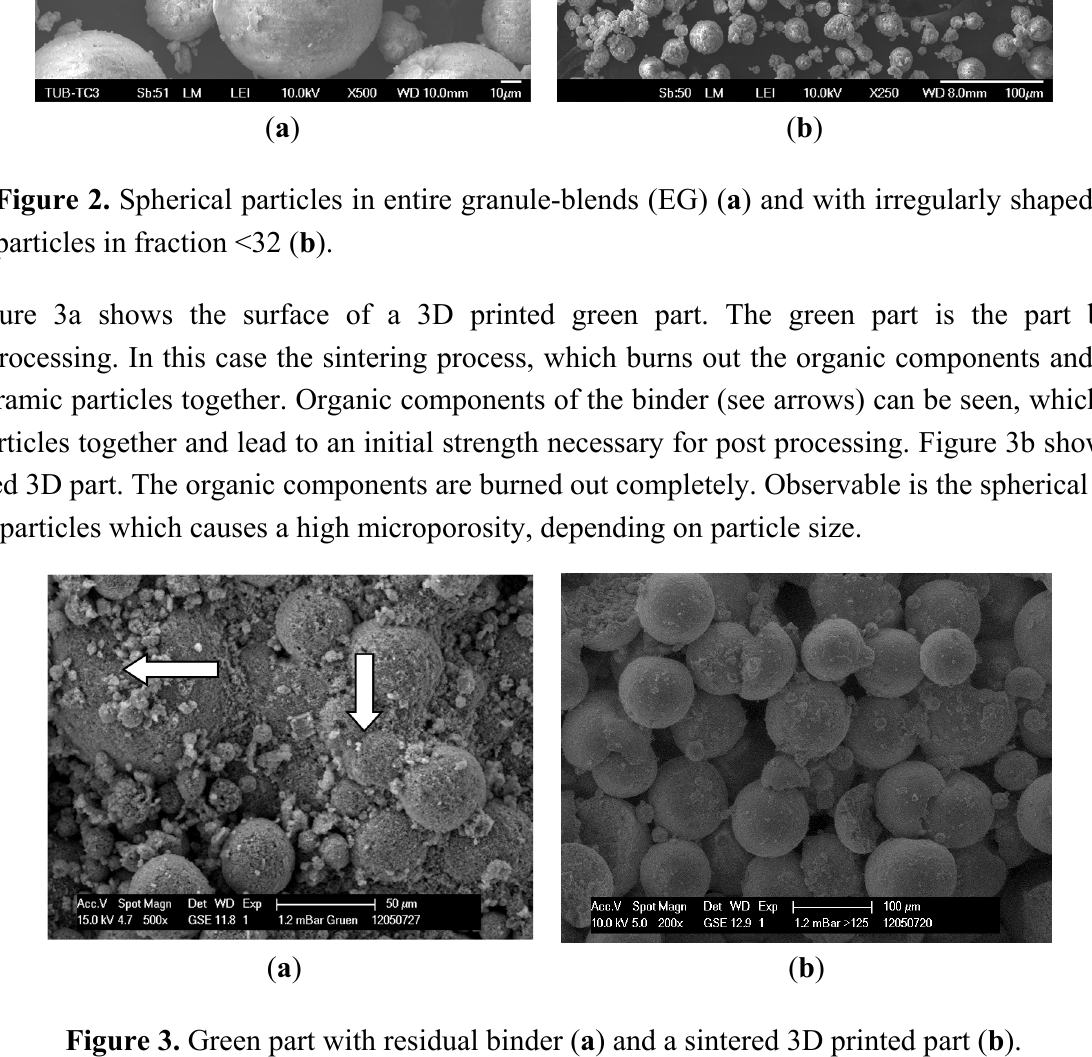
Figure 3. Green part with residual binder ( a ) and a sintered 3D printed part ( b